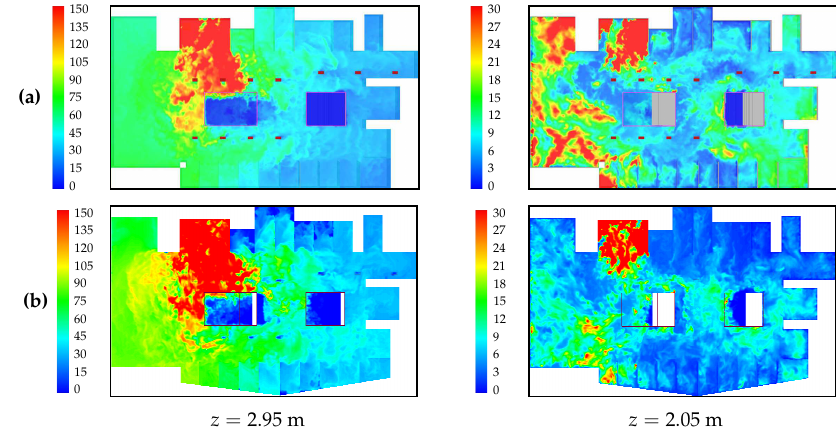
10 4 ) at t = 240 s and heights z = 2.95 m (left column) 2 ×